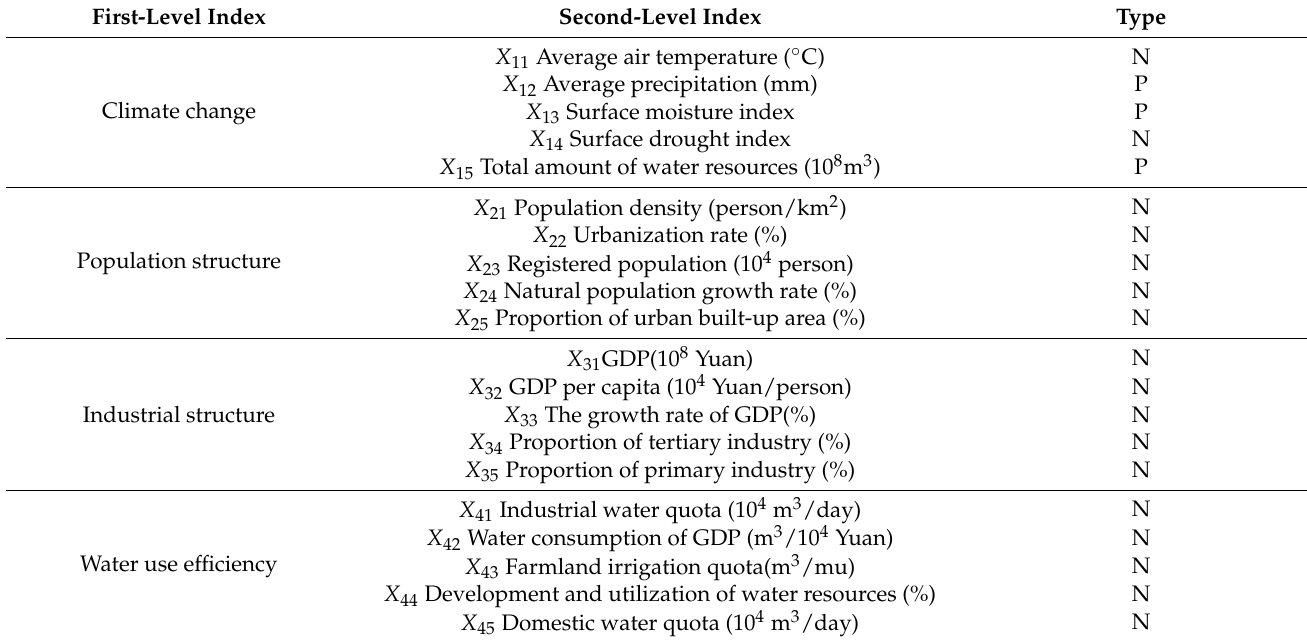
Table 3. Index system of hazards of disaster-causing